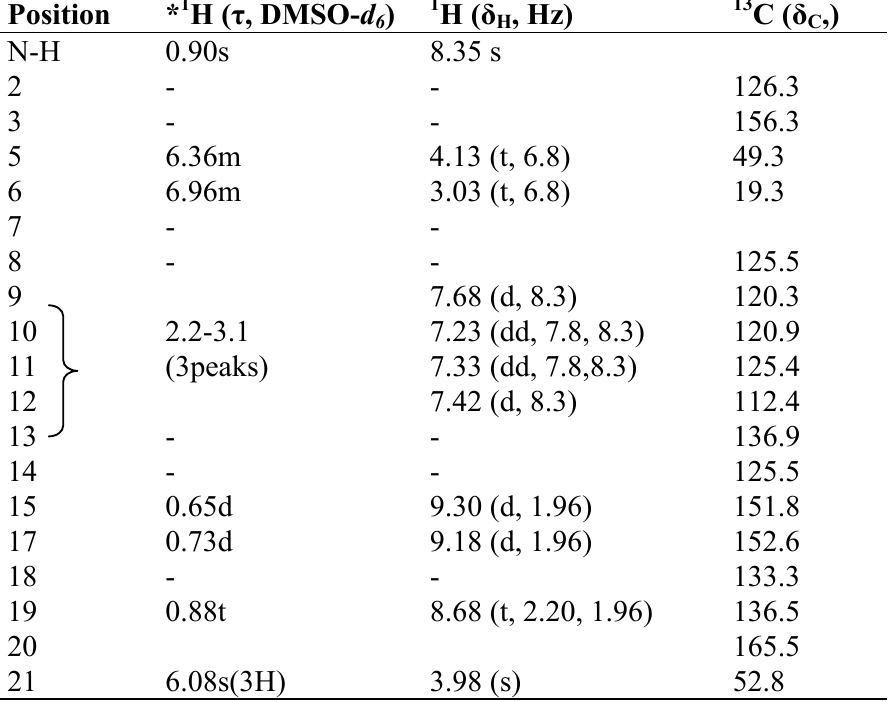
) spectral data 3